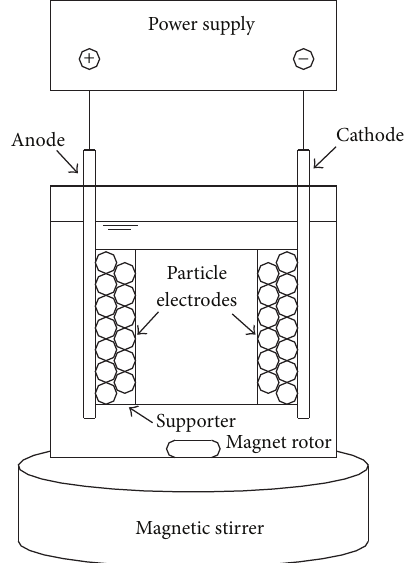
Figure 1: Schematic diagram of experimental